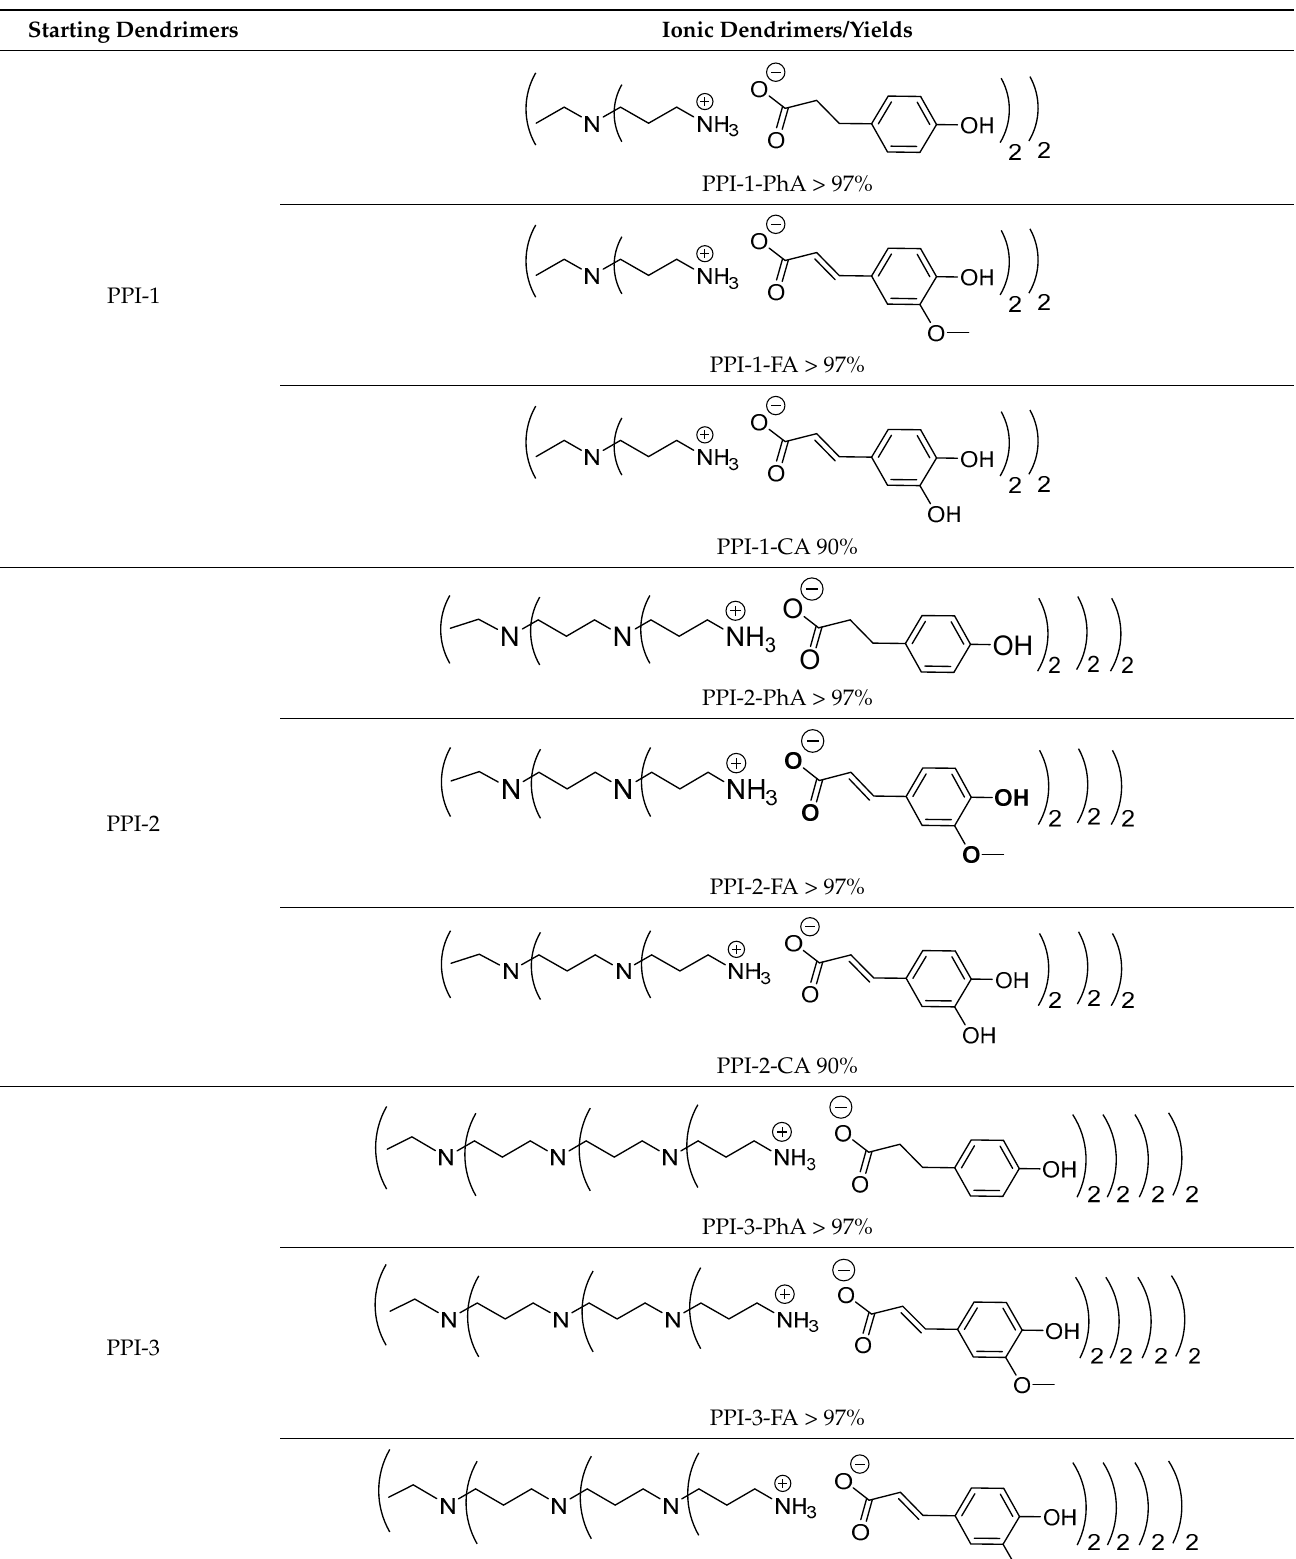
Table 1. Ionic PPI-derived dendrimers.